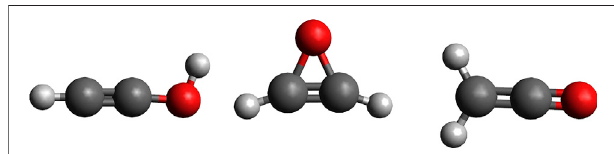
FIGURE 1 | From left to right: ethynol, oxirene, and